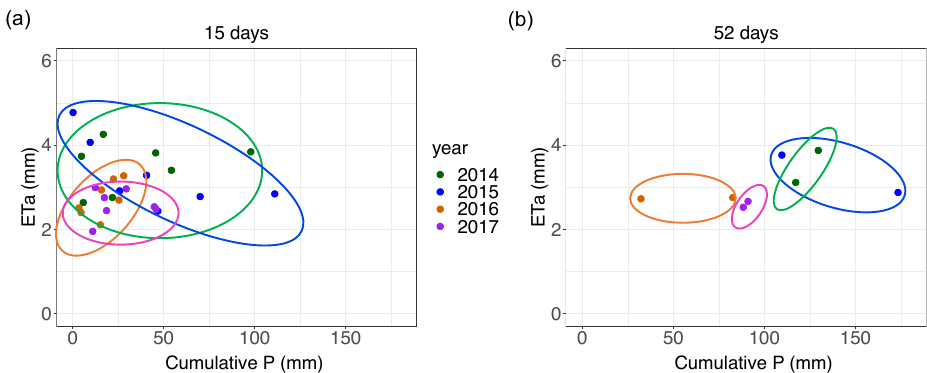
Figure 12. ( a ) Actual evapotranspiration (ETa) versus cumulative precipitation (cumulative P ) consid- ering 15-days periods for each growing season. ( b ) Actual evapotranspiration (ETa) versus cumulative precipitation (cumulative P ) considering 52-days periods for each growing season. Ellipses highlight the different regions of the plane in which the data lay in different years. The cumulative actual evapotranspiration was normalised by the number of days of each considered time